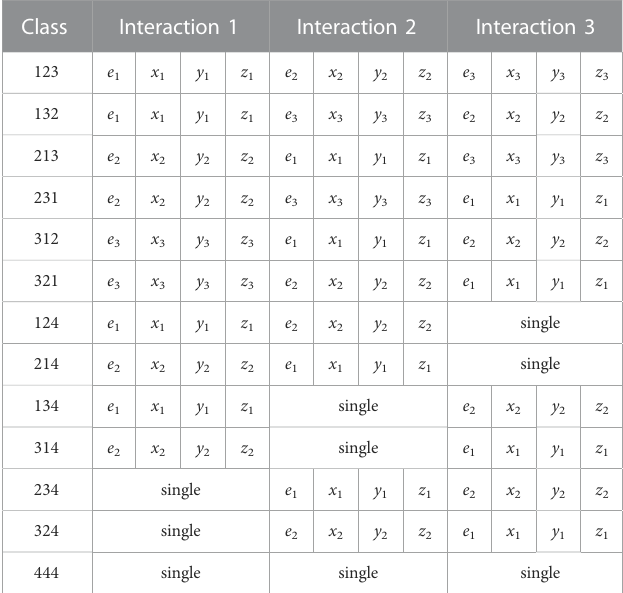
TABLE 1 The input class as the left column and the remaining columns contain the interaction data with subscripts for the correct interaction number. The top row indicates the order the interaction data will be fed into the neural